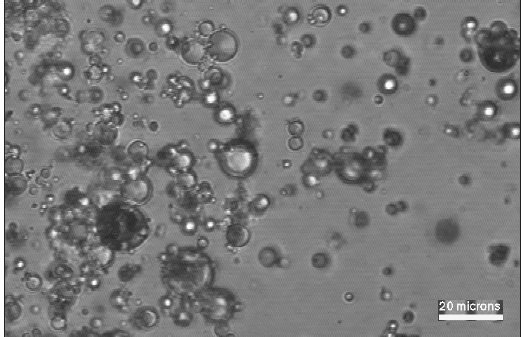
Figure 7 (left): Mixture of hydrophilic glass spheres suspension and PGPR emulsion after 100s mixing time.